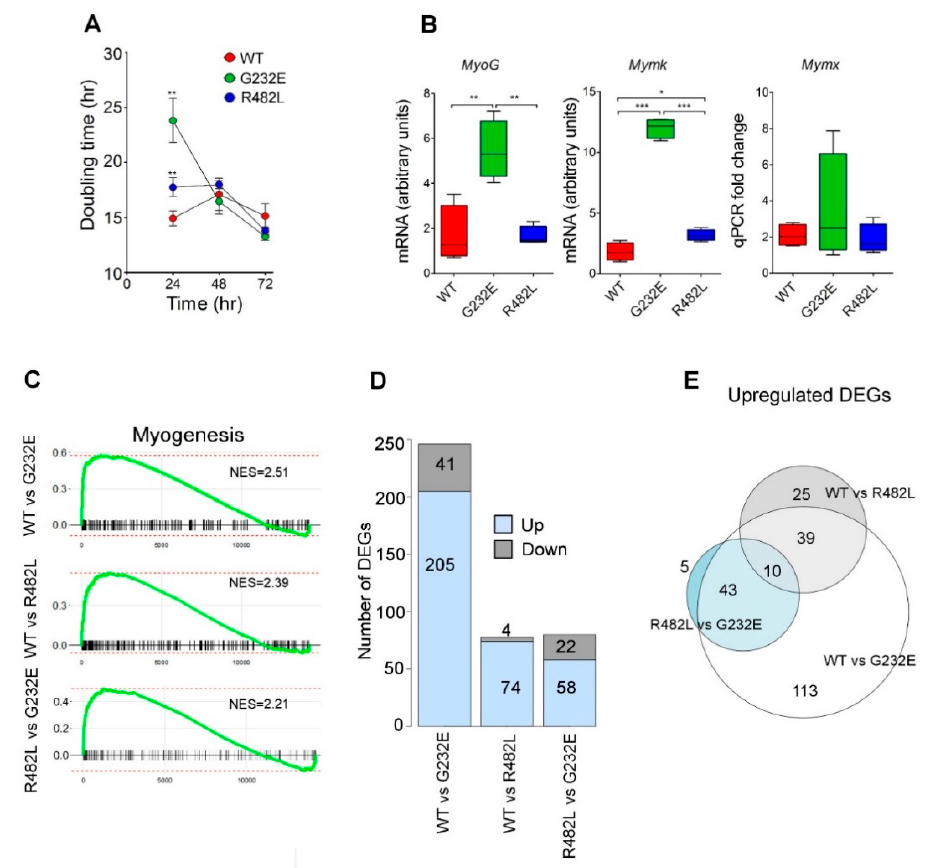
Figure 2. G232E/R482L-LMNA—induced alterations in functional properties of C2C12 myoblasts: ( A ) Estimation of the cell population doubling time for C2C12 cell lines, transduced with WT-LMNA, G232E-LMNA, and R482L-LMNA at three time points until 72 h. Values are mean ± SEM ( n = 4). ** p < 0.01; ( B ) mRNA expression of the genes that regulate the early steps of myogenic differentiation in C2C12 myoblasts. ( n = 4; * p < 0.05; ** p < 0.01; *** p < 0.001); ( C ) GSEA enrichment plots of the hallmark myogenesis pathway over ranked genes between all possible pairs of C2C12 myoblasts: WT versus G232E-LMNA, WT versus R482L-LMNA, and R482L-LMNA versus G232E-LMNA. ( p -adjusted < 0.001, normalized enrichment scores (NES) are shown); ( D ) number of up- and downregulated differentially expressed genes (DEGs) found in all three pairs (log2 fold change > 1, p -adj < 0.01); ( E ) Venn diagrams of upregulated DEGs.